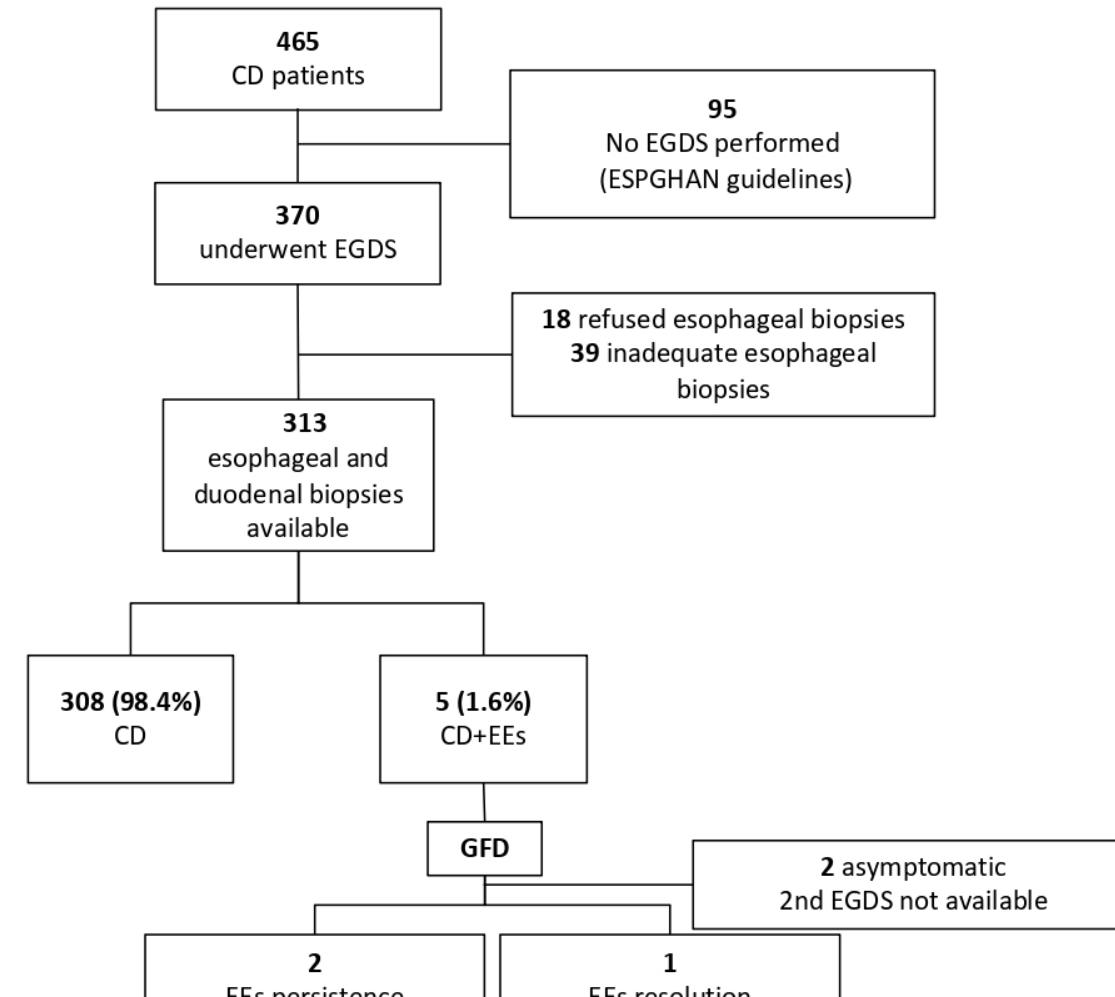
Figure 1. Flow diagram of participants. CD: Celiac disease; EoE: Eosinophilic esophagitis; EsEo: Esophageal eosinophilia; ESPGHAN: European Society of Gastroenterology, Hepatology and Nutrition; GFD: gluten-free diet.